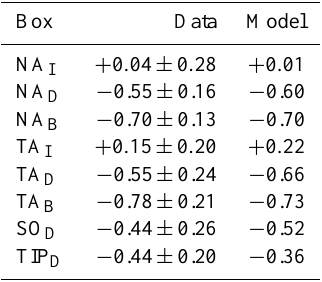
Table A5. Difference in δ 13 C-DIC between LGM (21kyr BP) and Holocene (5kyrBP) as derived from data (Oliver et al., 2010; Sarn- thein et al., 1994) and calculated in the standard model run. Box